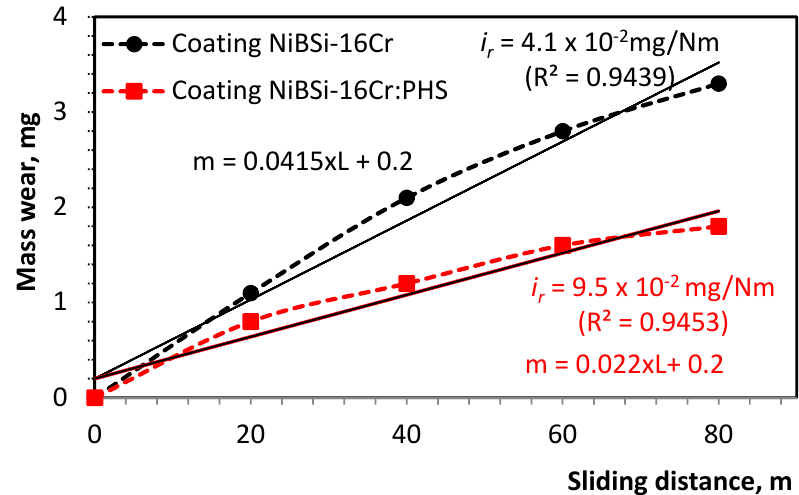
Figure 5. Mass wear vs. sliding distance for NiBSi-14Cr and NiBSi-14Cr: PHS coatings.